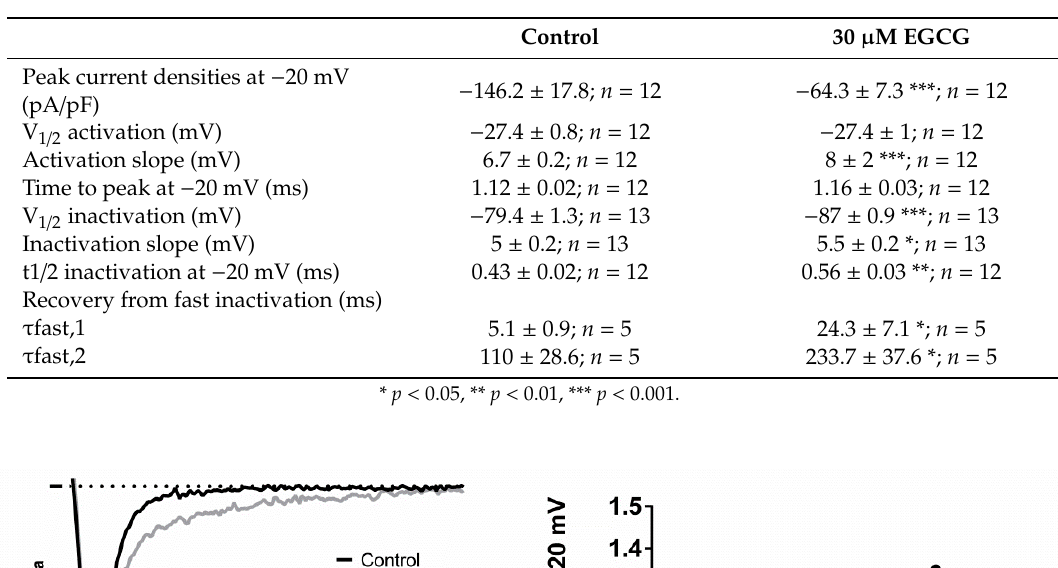
Table 1. E ff ect of EGCG on the gating properties of Na v 1.5 channels.